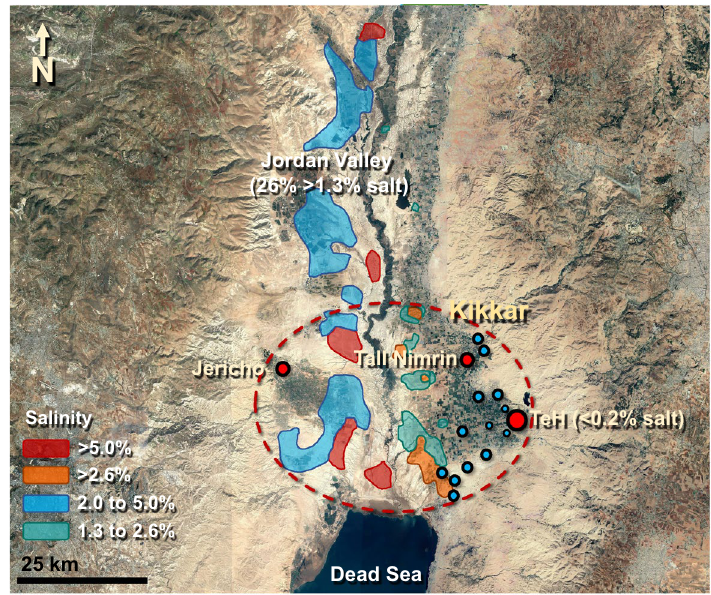
Figure 49. Salt and the 16 Cities of the Plain. Covering ~ 26% of the southern Jordan Valley, the colorized areas mark modern-day salinity concentrations of ≥ 1.3%, considered lethal for many domestic food crops. Tall el-Hammam (largest red dot) was the principal city in the area; Tall Nimrin was the next largest with smaller towns in blue. The dashed red oval indicates the extent of the Kikkar, known as the “disk of the Jordan”. All 16 major settled sites and > 100 villages in the southern Jordan Valley appear to have been abandoned at ~ 1650 BCE (3600 cal BP). Jericho was minimally resettled ~ 300 years after the destruction event. Tall Nimrin was resettled ~ 500 years later, and TeH was reoccupied ~ 600 years later. Source of base image: “The Southern Jordan Valley”. 35° 51.254 N, 35° 33.092 E. Google Earth; Maxar Technologies; CNES/Airbus. Imagery date: 10/29/2020; accessed: 4/4/2021. Permissions: https:// about. google/ brand- resou rce- center/ produ cts- and- servi ces/ geo- guide lines/ Modified by the authors using Adobe Photoshop CC2014 (adobe.com/products/photoshop.